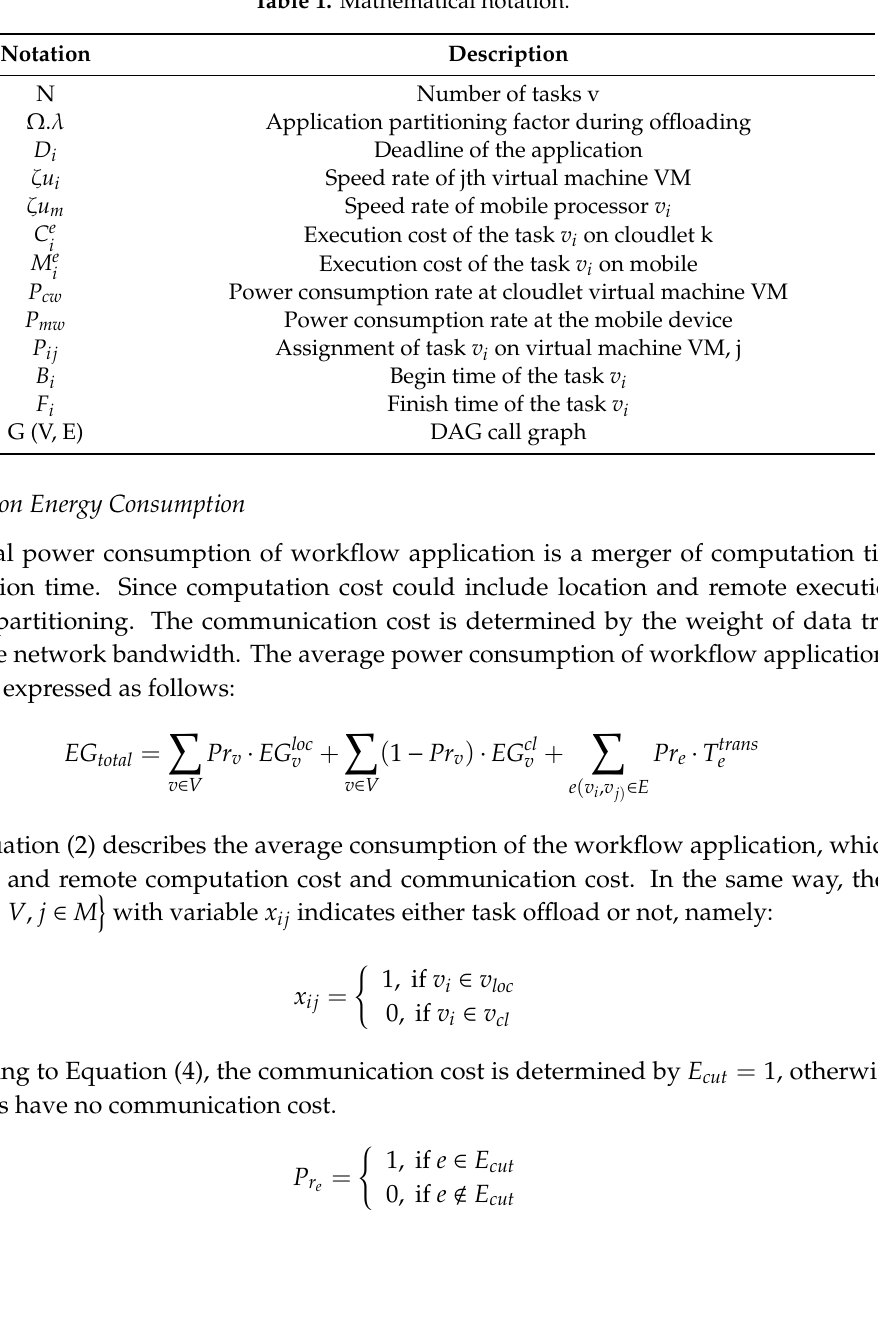
Table 1. Mathematical